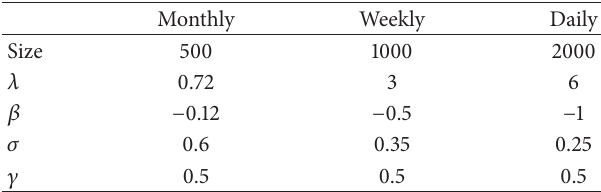
Table 2: Monte Carlo study parameters.